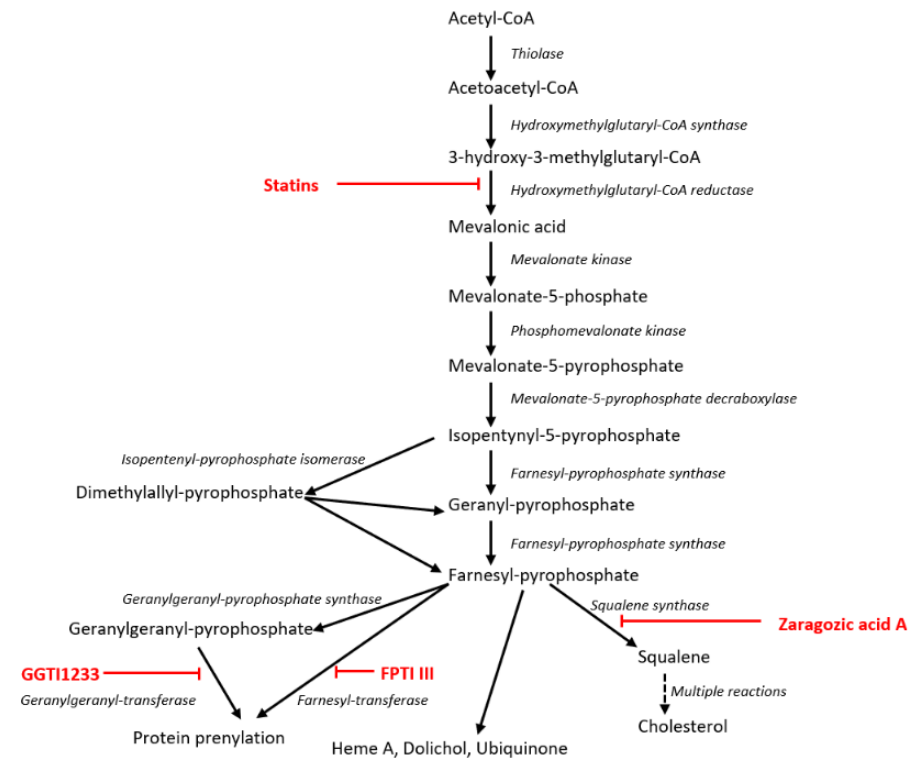
Figure 3. The mevalonate pathway of mammals. Key steps inhibited by statins (inhibition of HMG-CoA reductase), zaragozic acid A (inhibition of squalene synthase), geranyl-geranyl pyrophosphate or farnesyl pyrophosphate inhibitors are indicated.